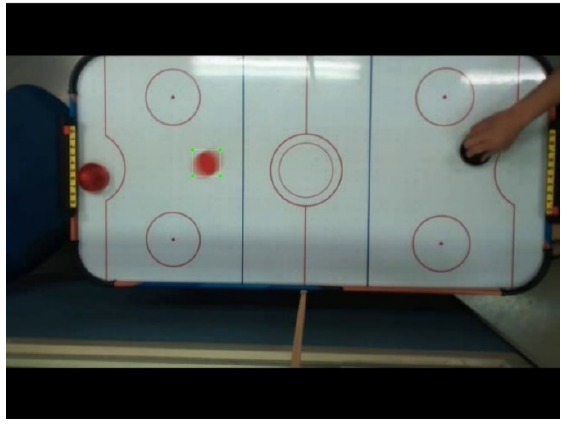
Figure 6. Image of hockey moving fast.